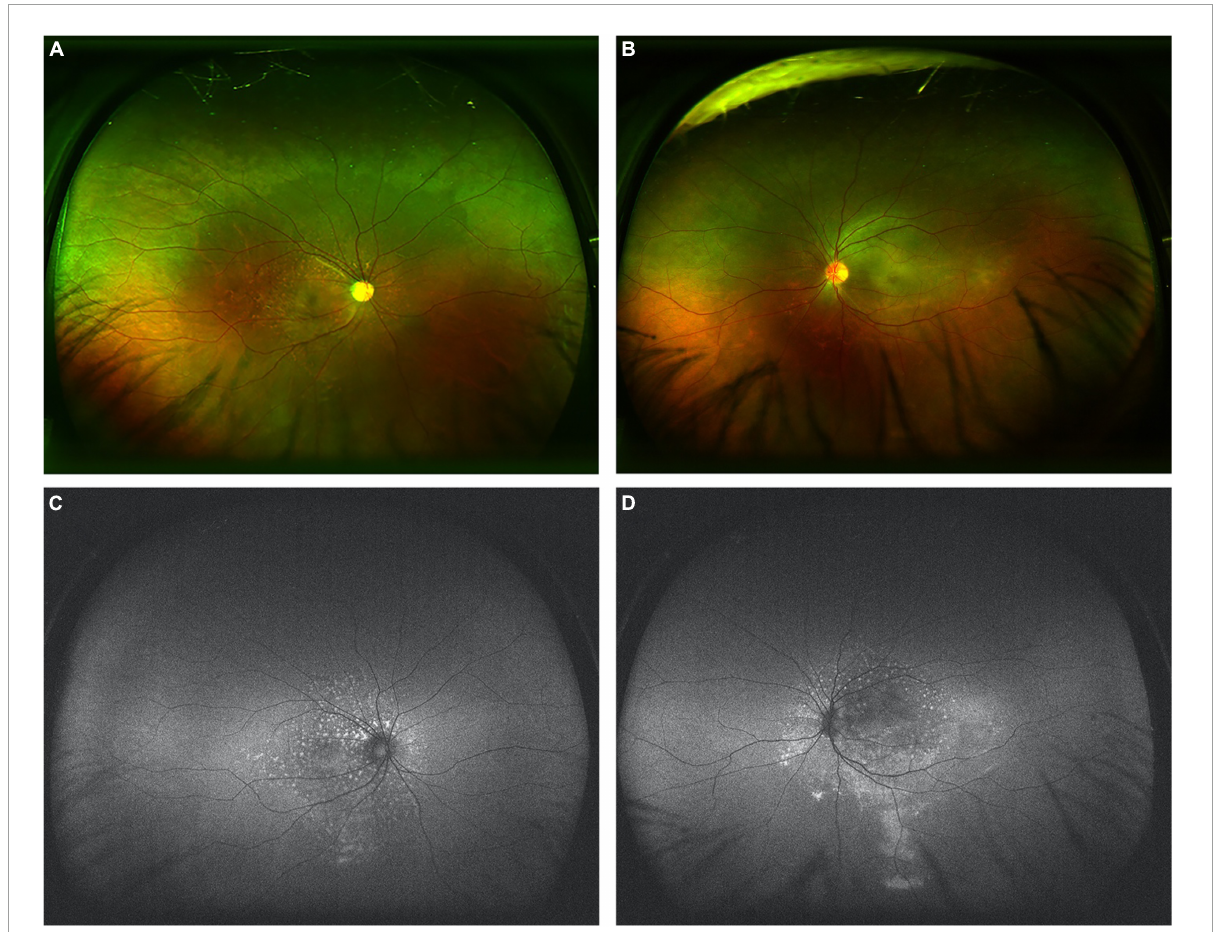
FIGURE2 Ultrawide-field color pictures and autofluorescence in both eyes. (A,B) Ultrawide-field color pictures showed mild retinal venous dilation without hemorrhages and numerous flecks with subtle yellow subretinal flecks surrounding the papillomacular region. (C,D) Fundus autofluorescence showed mild hypo-autofluorescence in the foveal center and marked hyper-autofluorescence of these flecks surrounding the optic nerve head and macular region in both eyes. In left eye, gravitational track was observed on fundus